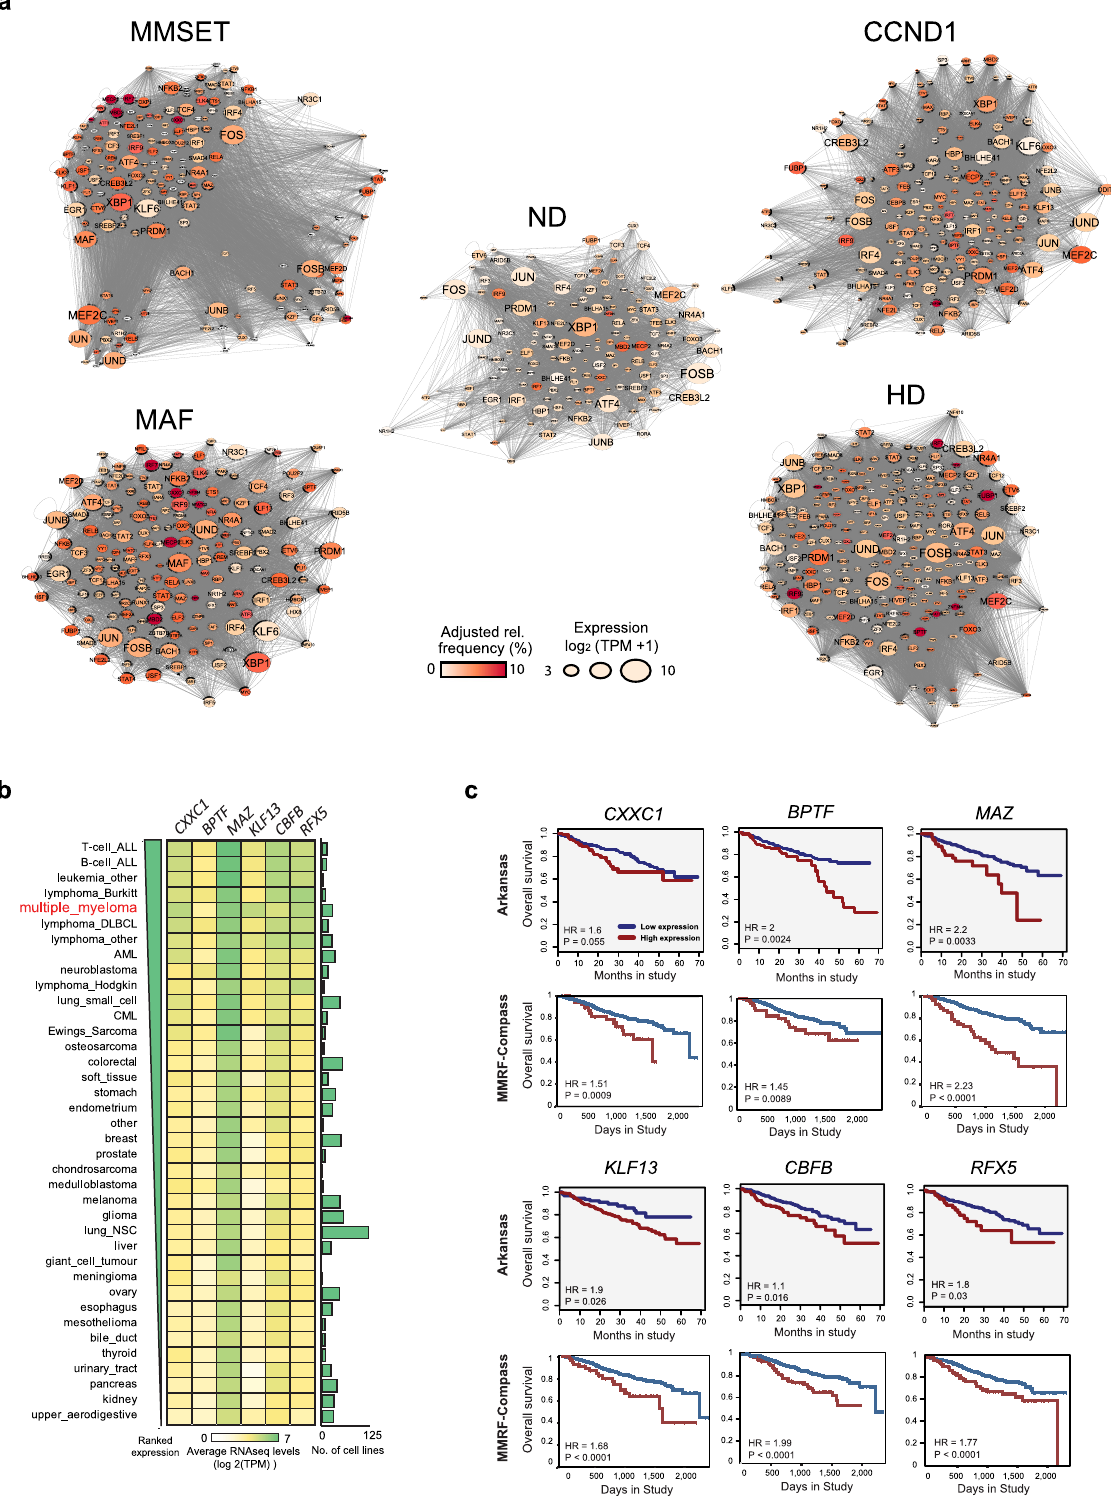
Fig. 4 TF regulatory gene networks provide biological and clinical insights into MM disease. a TF regulatory gene networks per myeloma subgroup and normal donor PC, as inferred from footprinting analysis. TF are weighed by relative TF binding frequency (colour) and expression (node size). b Heatmap of ranked expression of CXXC1 , BPTF , MAZ , KLF13, CBFB and RFX5 across >1000 human cancer cell lines (CCLE dataset). Multiple myeloma cell lines are highlighted in red. Bar plot depicts the number of cell lines per cancer group. c MM patient strati fi cation based on CXXC1 , BPTF , MAZ , KLF13, CBFB and RFX5 expression (red, high; blue, low) and analysis of overall survival using the Multiple Myeloma Arkansas ( n = 414) and the MMRF Compass Dataset ( n = 745). HR hazard